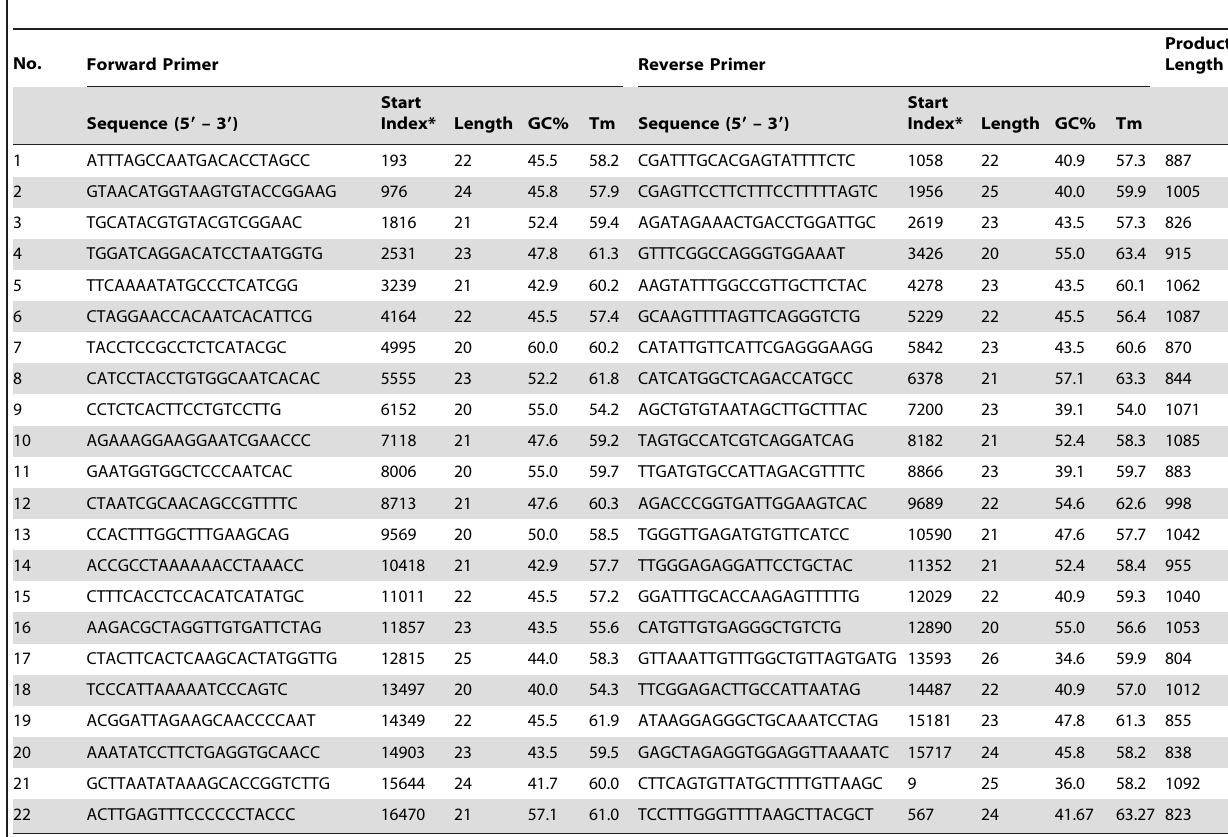
Table 1. A set of primers for amplifying entire circular